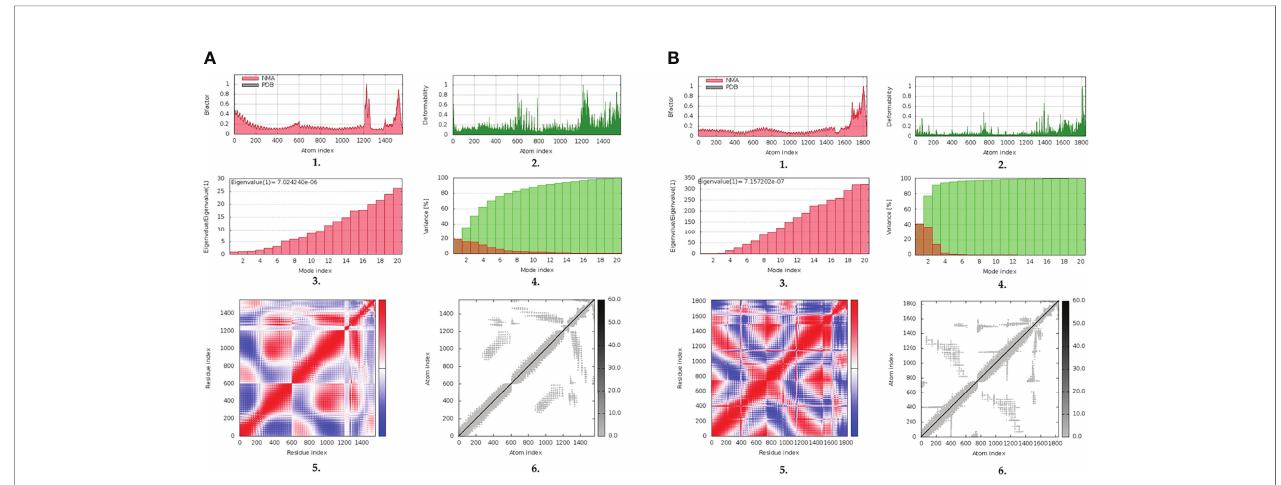
FIGURE 5 | Normal-state analyses via iMODS server for the docked multitope vaccine/TLR complexes; (A) multitope vaccine/TLR-4; (B) multitope vaccine/TLR-8 models. Ligand-receptor interaction was assessed throughout comparative 1. B-factor indices, 2. deformability, 3. variances, 4. eigenvalues, 5. covariance of residue indices, and 6. elastic network